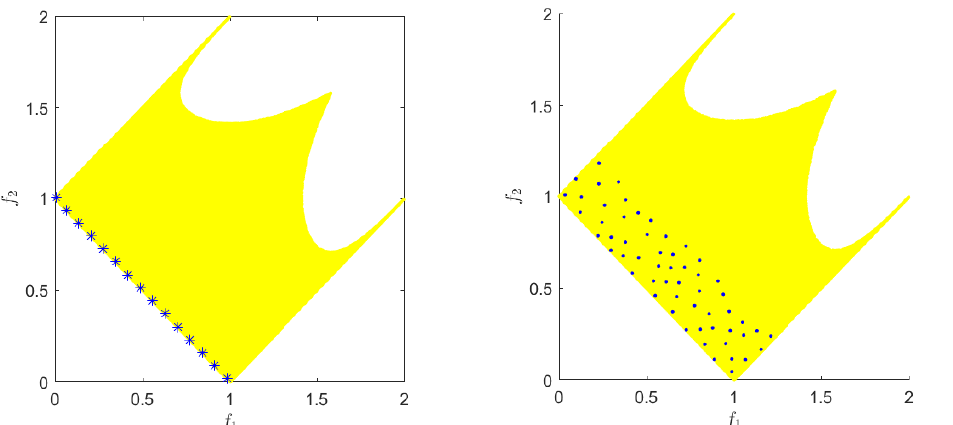
Figure 2. The figure shows in yellow the feasible space and in blue the first rank for each subpopulation on LSS with α = 0.5—on the left, the first ranked solutions that aim for the global Pareto front, on the right, the first ranked solutions that aim for the set of approximate solutions. 1. Migration: every n f generations, nr individuals are exchanged between the population. The individuals are chosen at random from the rank one individuals. 2. Crossover between subpopulations: every n f generations, the crossover is performed between the populations. One parent is chosen from each population at